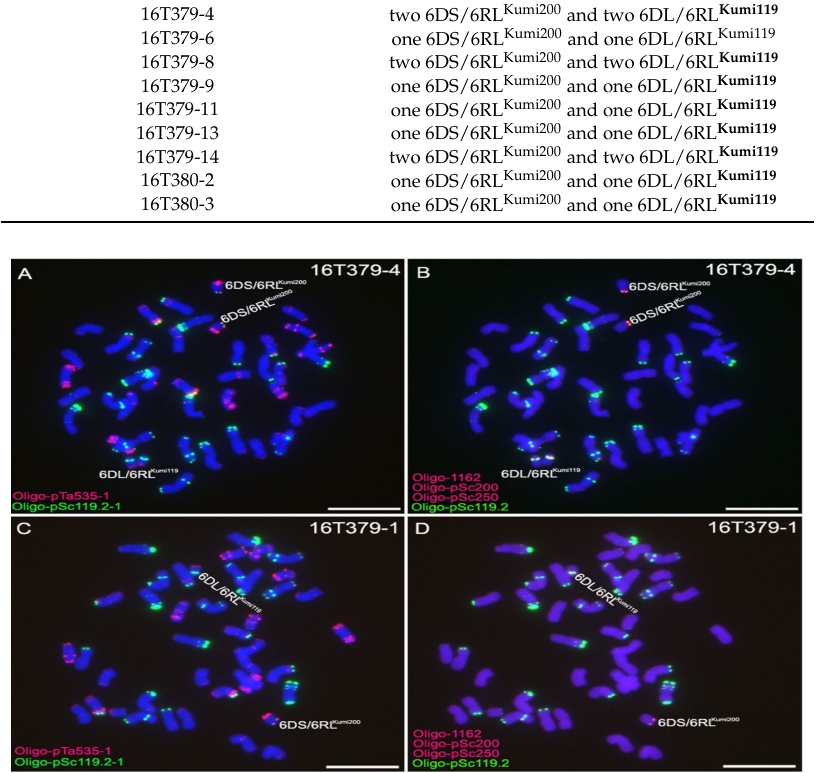
Figure 2. Oligo-pTa535-1 ( red ), Oligo-pSc119.2-1 ( green ), Oligo-1162 ( red ), Oligo-pSc200 ( red ), and Oligo-pSc250 ( red ) were used as probes for ND-FISH analysis of wheat-rye 6D/6RL Ku small segment translocation lines. ( A , B ) Line 16T379-4 represents lines with two 6DS/6RL Kumi200 and two 6DL/6RL Kumi119 chromosomes. ( A ) and ( B ) are the same cell. ( C , D ) Line 16T379-1 represents lines with one 6DS/6RL Kumi200 and one 6DL/6RL Kumi119 chromosome. ( C ) and ( D ) are the same cell. Chromosomes were counterstained with DAPI ( blue ). Scale bar 10 µ